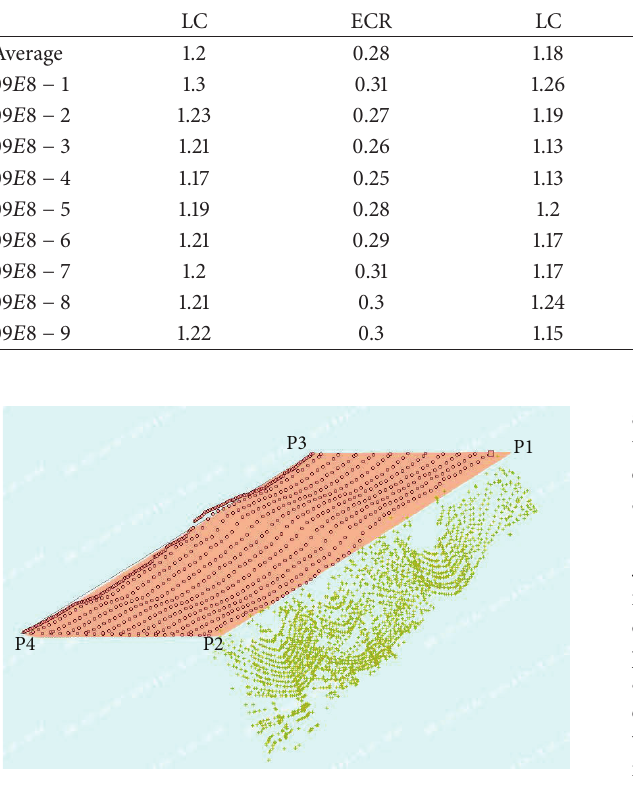
Figure 8: Generated vector graph by importing bench data.